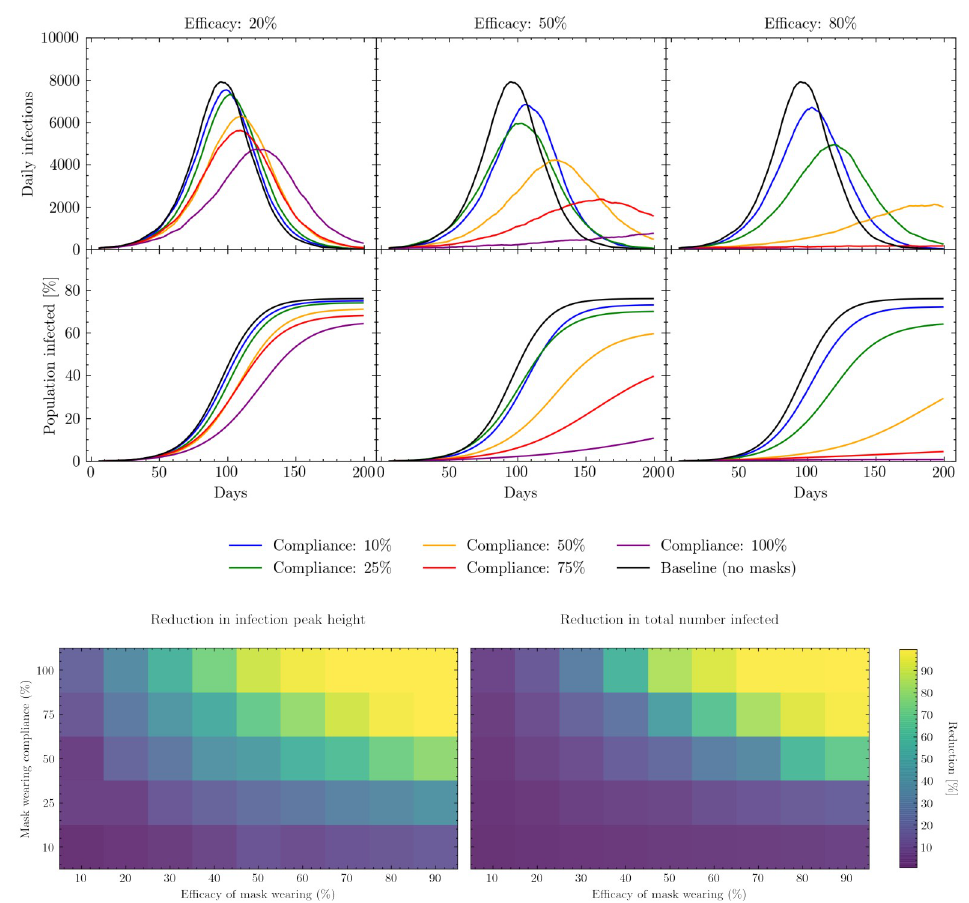
Fig 7. Mask wearing simulation results. Upper: Simulated daily (7-day rolling average) and cumulative infections measured in days since the beginning of the simulation. Results show the effects of varying the compliance with mask wearing in different locations under different assumptions regarding mask efficacy. The baseline model is the scenario in which no masks are worn. See S1 Table for a presentation of the cumulative number of infections, peak intensity and peak timings for these scenarios. Lower left: percentage change in daily infection peak height as a function of mask wearing efficacy and compliance relative to the peak height of the baseline model. Lower right: percentage change in total number of infections up to a fixed point in simulated time as a function of mask wearing efficacy and compliance relative to the total number of infections simulated by the baseline model. The baseline model assumes no masks are